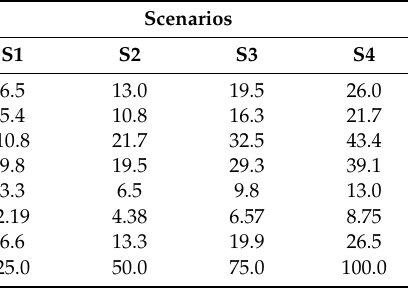
Table 4. Permeable brick pavement (PBP) implementation scenarios.